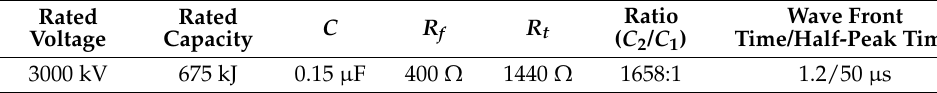
Table 1. Parameters of the impulse voltage generator.